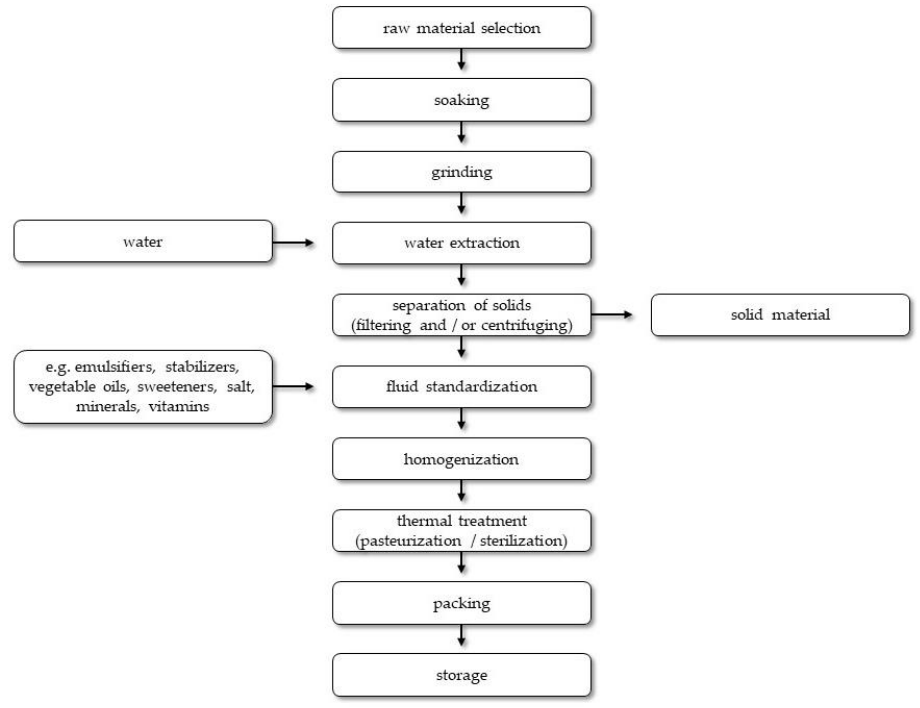
Figure 1. The general production technology of plant-based beverages. Plant-based beverages are complex media that contain small particles (e.g., fat drop-